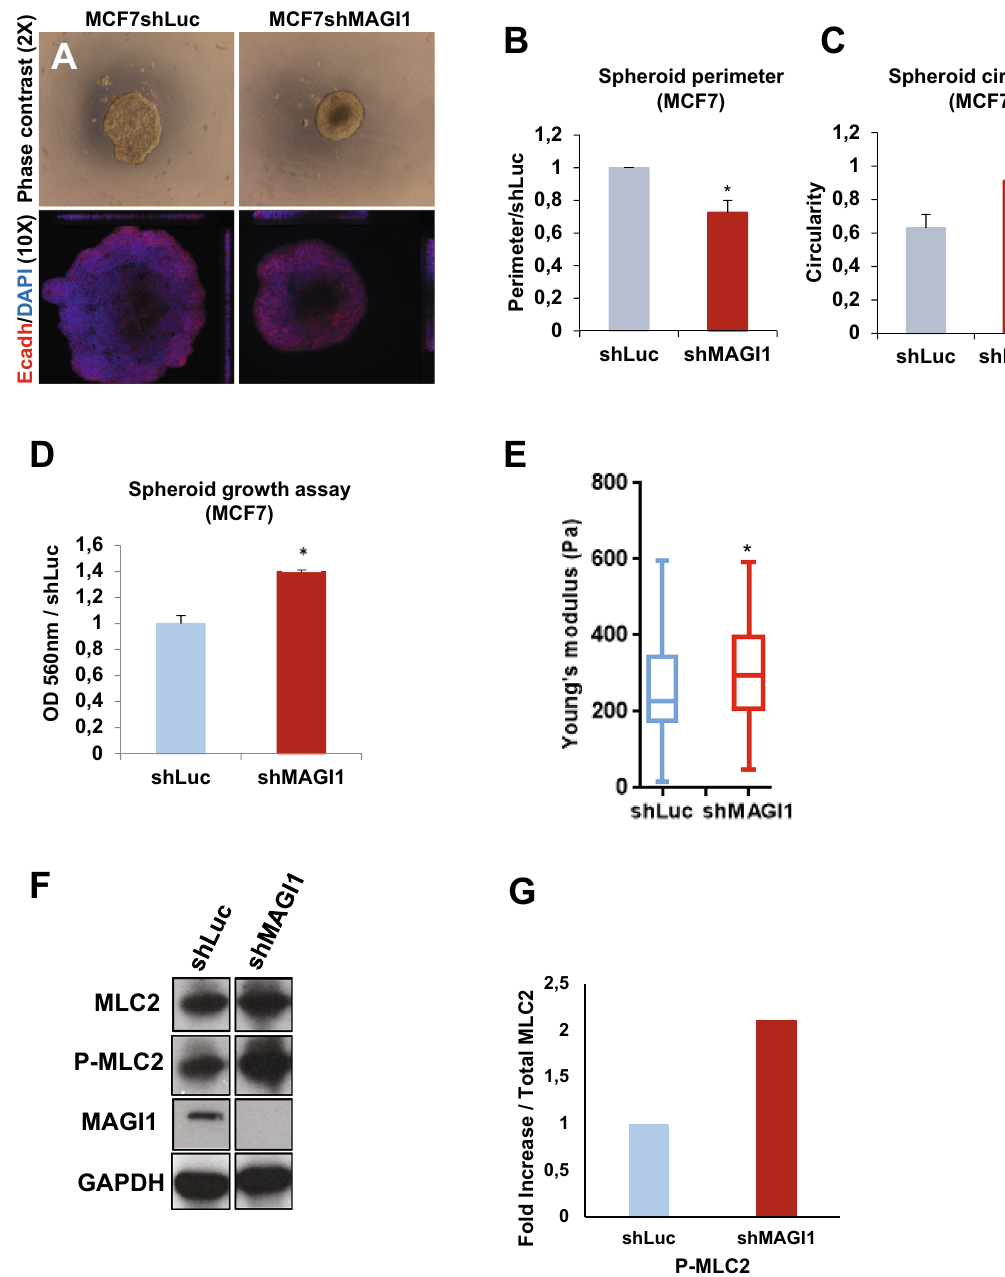
Figure 4. The loss of MAGI1 affects MCF7 cell compaction, ROCK activity, and compressive forces. ( A ) Representative phase contrast and fluorescence images of MCF7 shLuc and MCF7 shMAGI1 cells grown in 3D spheroid cultures and stained with E-cadherin (red) and DAPI (blue). ( B ) Calculated perimeters for 3D spheroid cultures of MCF7 shMAGI1 normalized by the perimeter of MCF7 shLuc cells. Bars represent mean ± SD (n = 10 spheroids) of five independent experiments. Unpaired two-tailed Student’s t-test; * p < 0.05. ( C ) Calculated circularity for 3D spheroid cultures of MCF7 shLuc and MCF7 shMAGI1 (calculations were done with the ImageJ software where a value of 1 is considered as a perfect circle). Bars represent mean ± SD (n = 10 spheroids) of five independent experiments. Unpaired two-tailed Student’s t-test; * p < 0.05. ( D ) MTT assay (OD 560 nm) representing 3D spheroid cell growth of MCF7 shMAGI1 compared to MCF7 shLuc cells 5 days after cell seeding. Bars represent mean ± SD (n = 10 spheroids) of five independent experiments. Unpaired two-tailed Student’s t-test; * p < 0.05. ( E ) Elastic Young’s modulus (EYM) of cells: Hertz contact mechanics model for spherical indenters was used. In MCF7 shMAGI1 cells, the apical surface EYM is significantly elevated when compared to control MCF7 shLuc cells. Data are represented as mean + /− SD: MCF7 shLuc EYM = 258.8 + /− 101, MCF7 shMAGI1 EYM = 302.4 + /− 91. Unpaired two-tailed Student’s t-test; * p < 0.05 (n = 132 and 94 for MCF7 shLuc and MCF7 shMAGI1 respectively). ( F ) Western blot analysis on whole protein extracts (n = 3) of ROCK-specific ser19 phosphorylation of Myosin Light Chain 2, total MLC2 and MAGI1 in MCF7 shMAGI1 cell lines compared to MCF7 shLuc . GAPDH was used as a loading control. Uncropped blots can be found in the Supplementary Information. ( G ) Quantification of the representative Western blot showing protein expression represented in panel E. Phosphorylated proteins were quantified as compared to their total protein counterparts to evaluate their